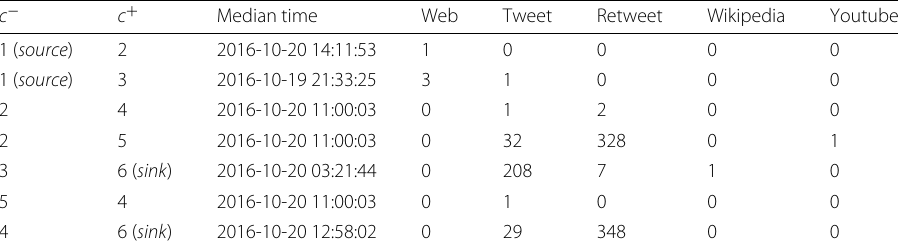
Table 5 Characteristic pairings of clusters selected from the Schiaparelli dataset Median time Web